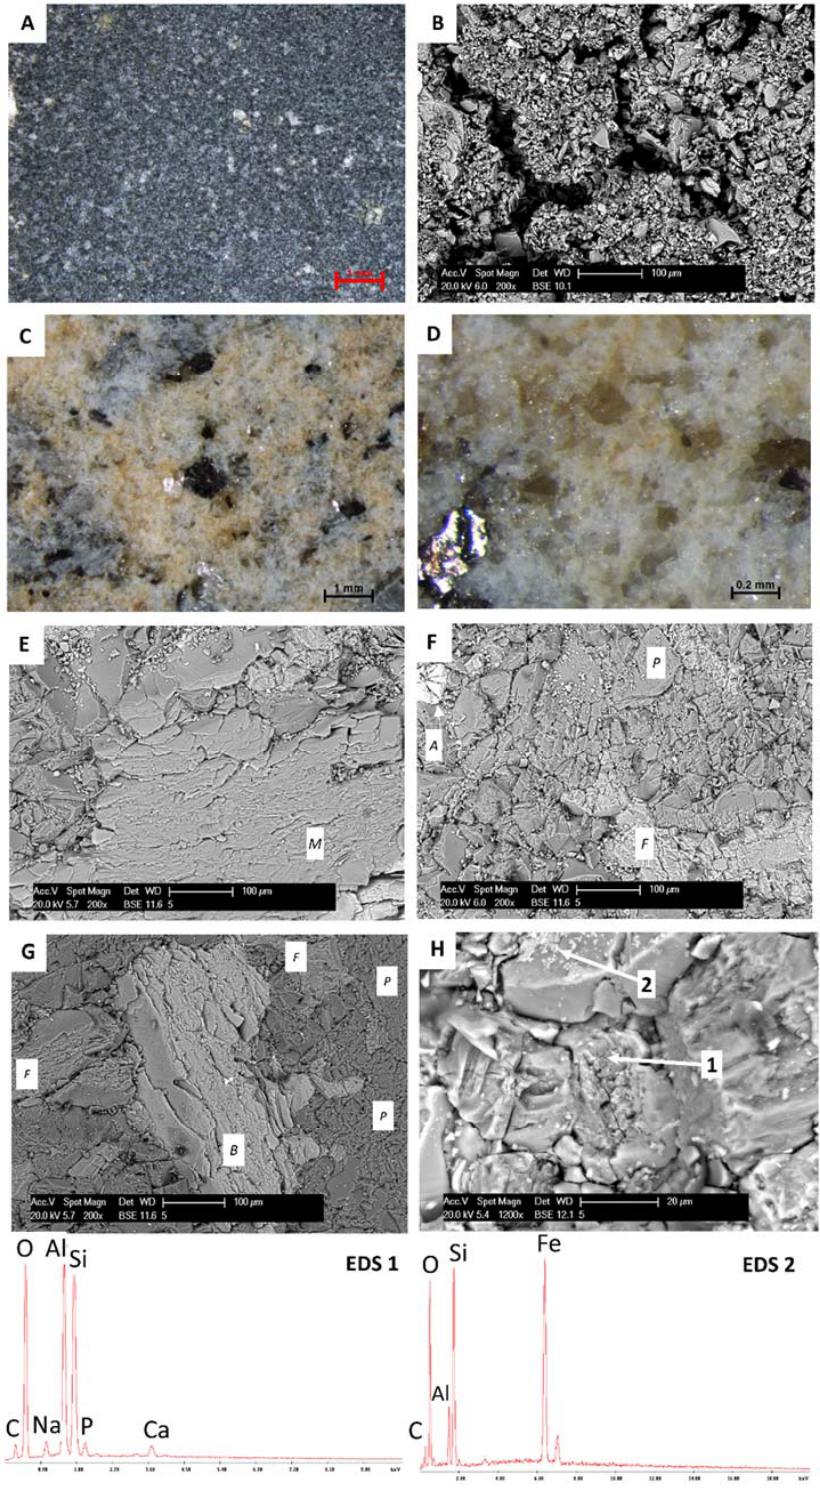
Figure 1. Micrographs taken with stereomicroscope ( A , C , D ) and scanning electron microscopy (SEM) Figure 1. Figure 1: Micrographs taken with stereomicroscope ( A , C,D ) and scanning electron ( B , E – H ) of the sub-aerial biofilms (SAB) developed on granite ( A , B ) and the uncoated granite ( C – H ). microscopy (SEM) ( B , E–H ) of the sub ‐ aerial biofilms (SAB) developed on granite ( A,B ) and the H is accompanied with the energy-dispersive x-ray spectroscopy (EDS) spectra. B: biotite, P: plagioclase, uncoated granite ( C–H ). H is accompanied with the energy ‐ dispersive x ‐ ray spectroscopy (EDS) F: feldspar; Q: quartz; A: spectra. B: biotite, P: plagioclase, F: feldspar; Q: quartz; A: apatite.